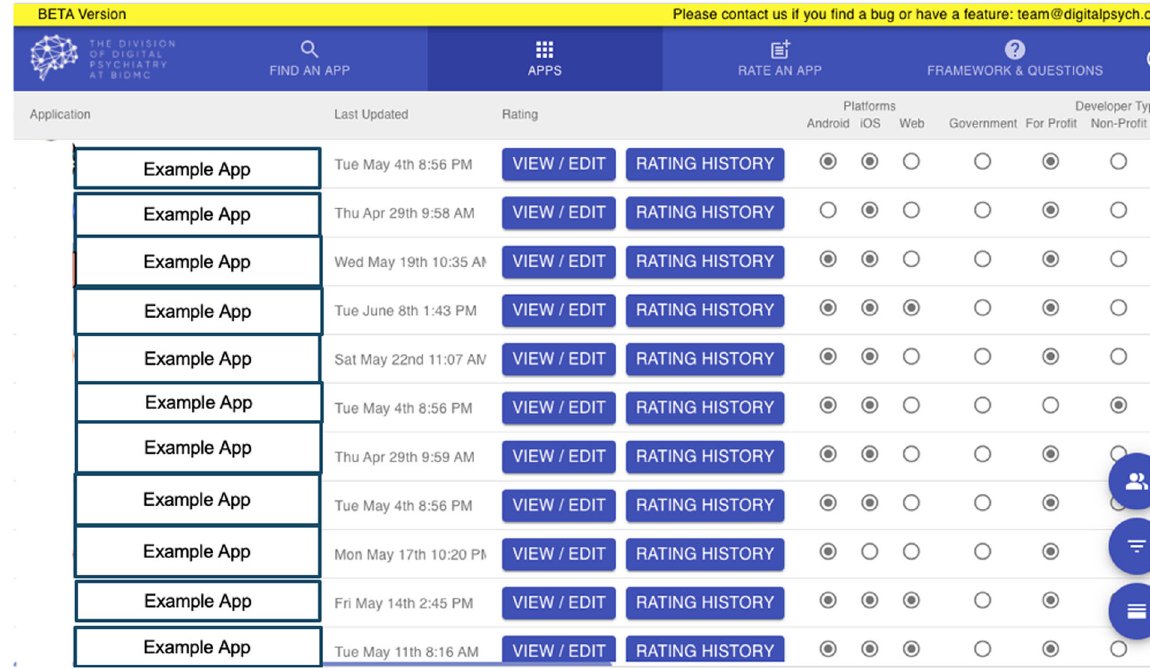
Fig. 3 Database Sort App Feature. Users can sort apps based on desired criteria and compare features.